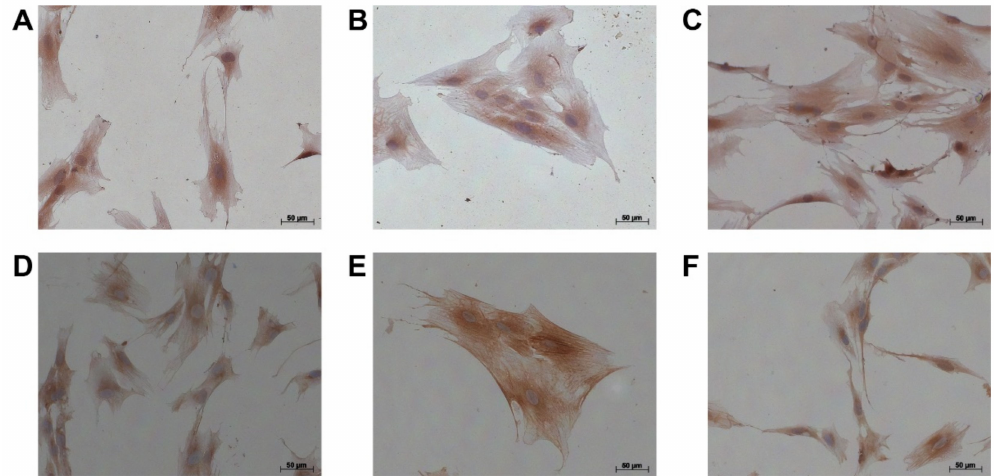
Figure 8. Immunocytochemistry of α SMA and CXCL12 in disease-associated fibroblasts from pancreatic cancer and chronic pancreatitis patients. Cells from ( A ) patient1, ( B ) from patient2, and ( C ) from patient3 for α SMA staining, ( D ) cells from patient1, ( E ) from patient2, and ( F ) from patient3 for CXCL12 staining. Bar: 50 µ